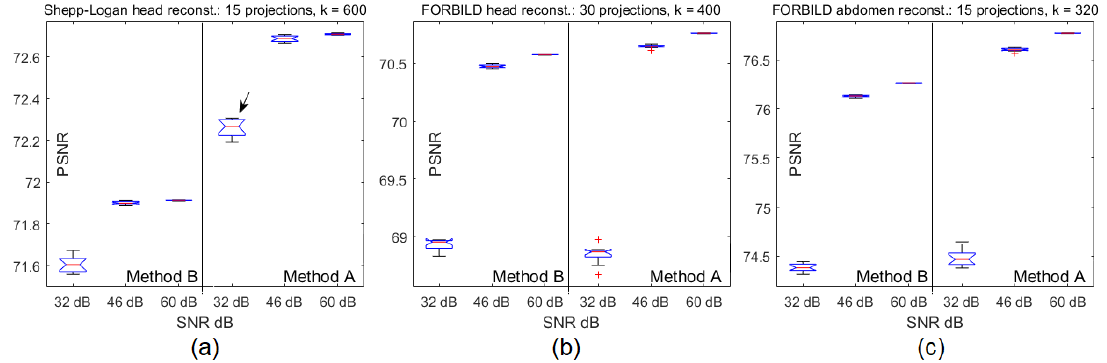
Figure 11. ( a ) Box plot graph for the Shepp–Logan head reconstruction with 15 projections and k = 600, ( b ) box plot graph for the FORBILD head phantom with 30 projections and k = 400, and ( c ) box plot graph for the FORBILD abdomen phantom with 15 projections and k =